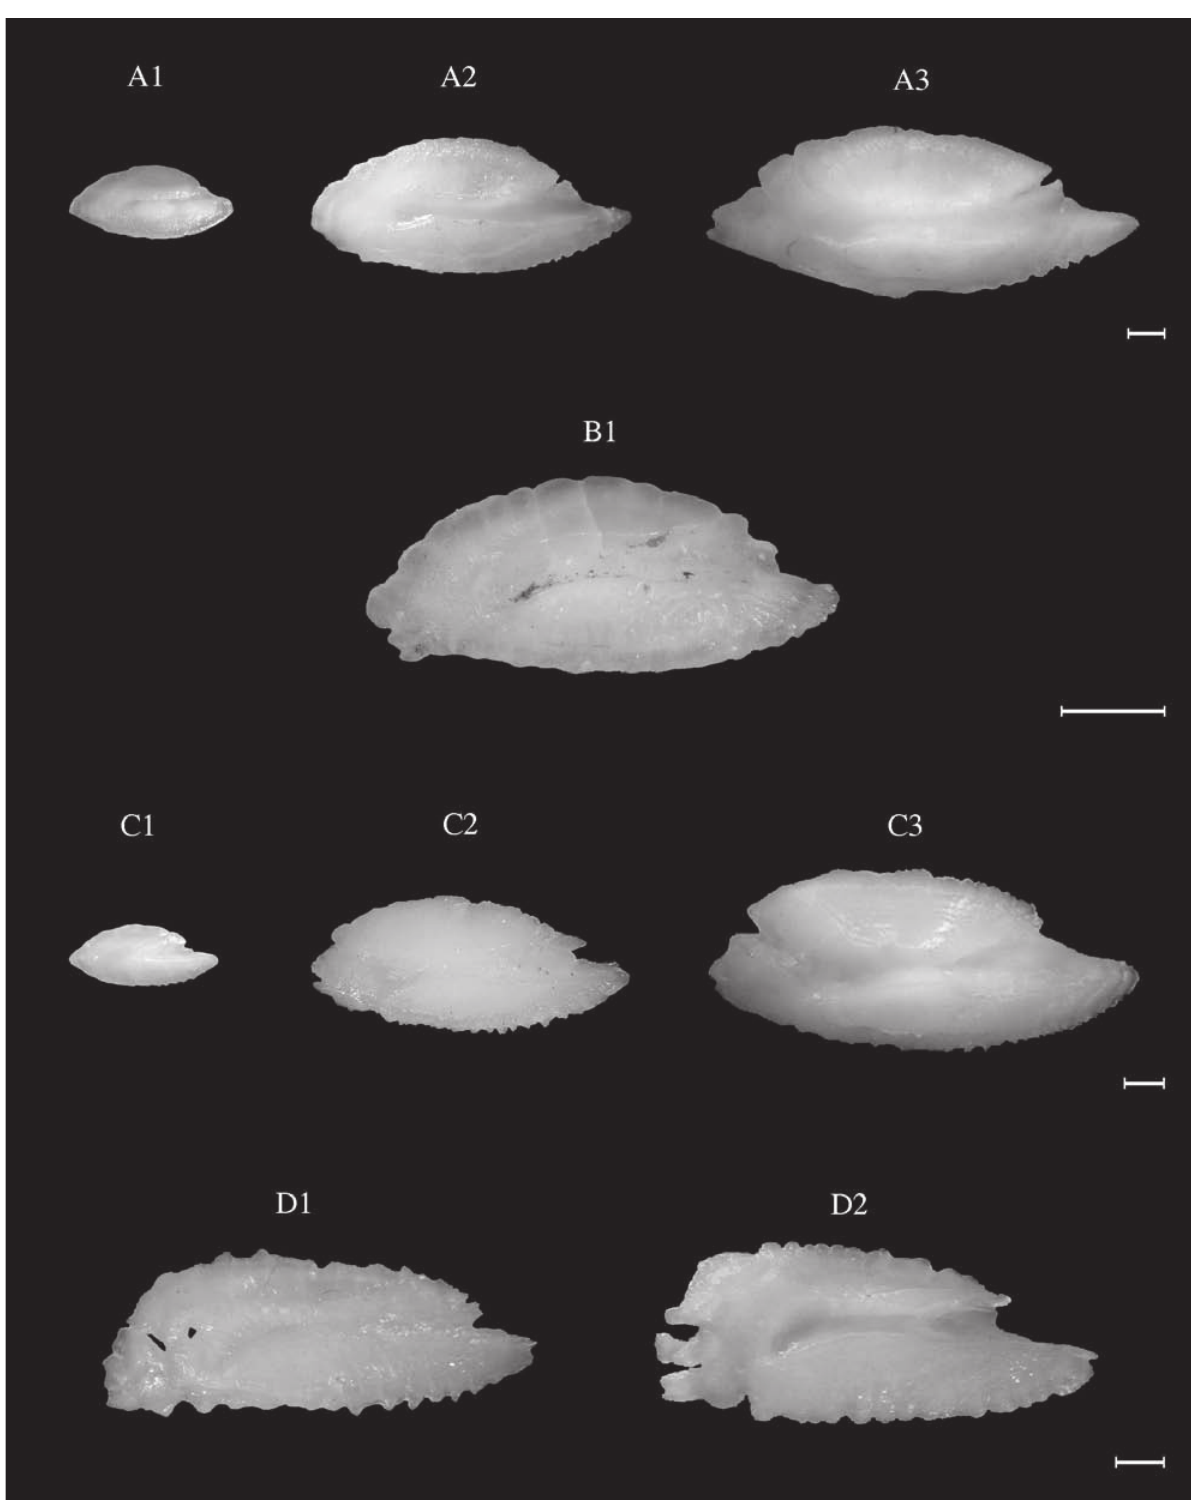
Fig. 42. – Scorpaena elongata (WM). TL: A1, 7.0 cm; A2, 17.0 cm; A3, 21.0 cm. Scorpaena maderensis (CEA). TL: B1, 10.5 cm. Scorpaena notata TL: C1, 7.0 cm (NEA); C2, 13.0 cm (CEA); C3, 20.0 cm (WM). Scorpaena porcus TL: D1, 20.0 cm (CEA); D2, 22.5 cm (WM). Scale bar = 1